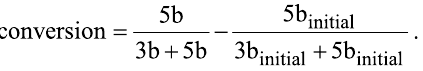
Figure NMR 5 and Table NMR 5 correspond with 15a , while Figure NMR 6 as well as Table NMR 6 and Table NMR 7 show the results for 15b